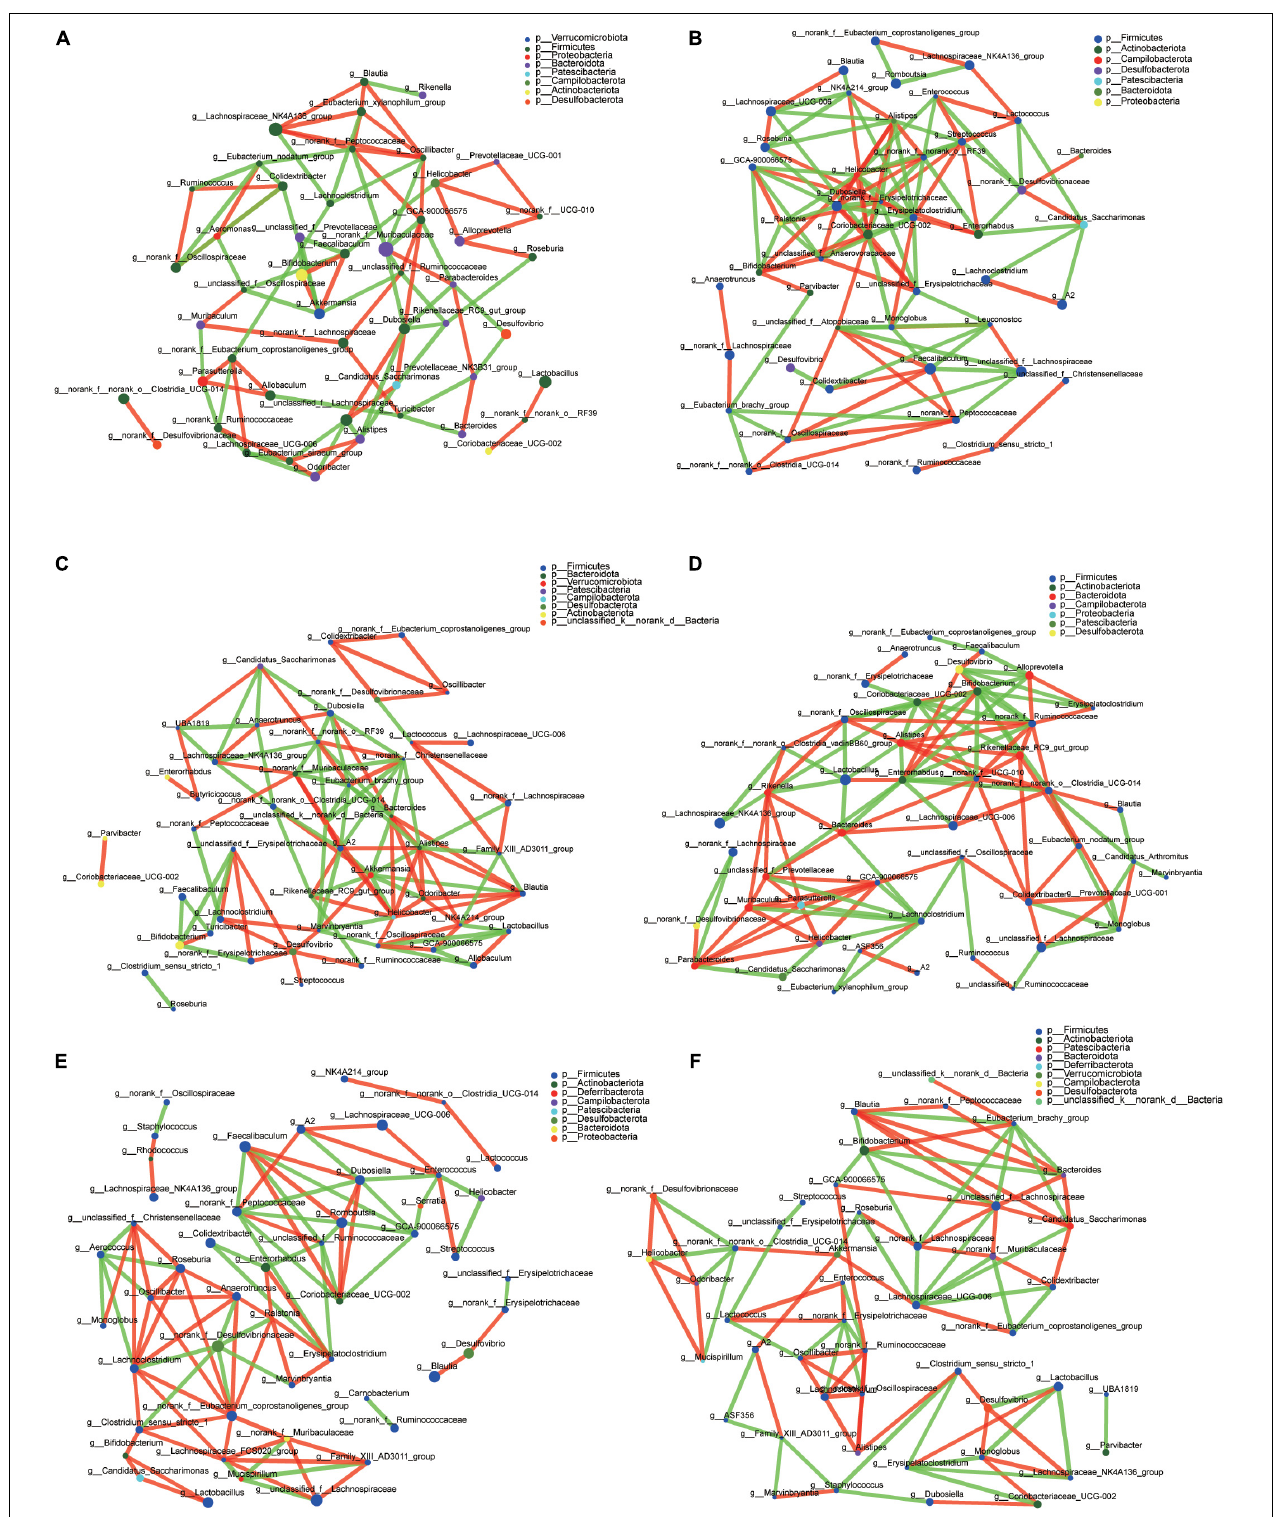
FIGURE 7 | Microbiota correlation network of different groups. (A) Correlation network of CT. (B) Correlation network of CH. (C) Correlation network of CHI. (D) Correlation network of OT. (E) Correlation network of OH. (F) Correlation network of OHI. The red line indicates a positive correlation ( p > 0.06), and the green line indicates a negative correlation ( p <